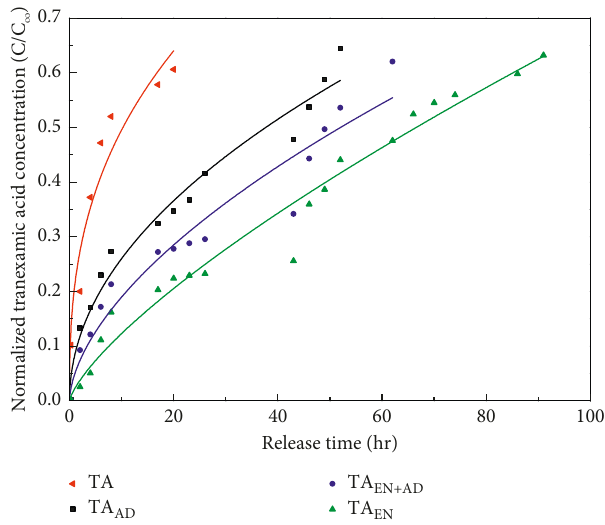
Figure 3: Curve fitting of tranexamic acid release in various emulsified Table 3: Curve fitting for fractional solute concentration over time. Formulation